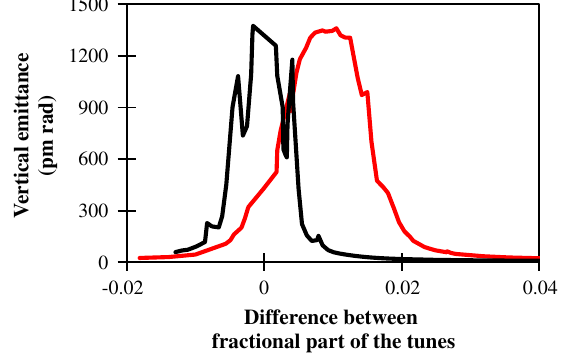
FIG. 6. Variation of the measured vertical emittance as a function of the distance between the transverse tunes. Black: low current per bunch. Red: 20 mA current per bunch.